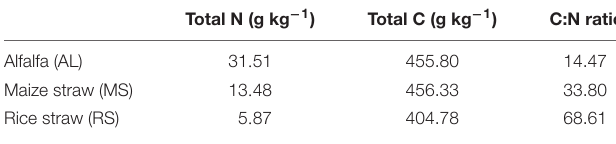
TABLE 1 | Nutrient contents of maize, rice straw, and